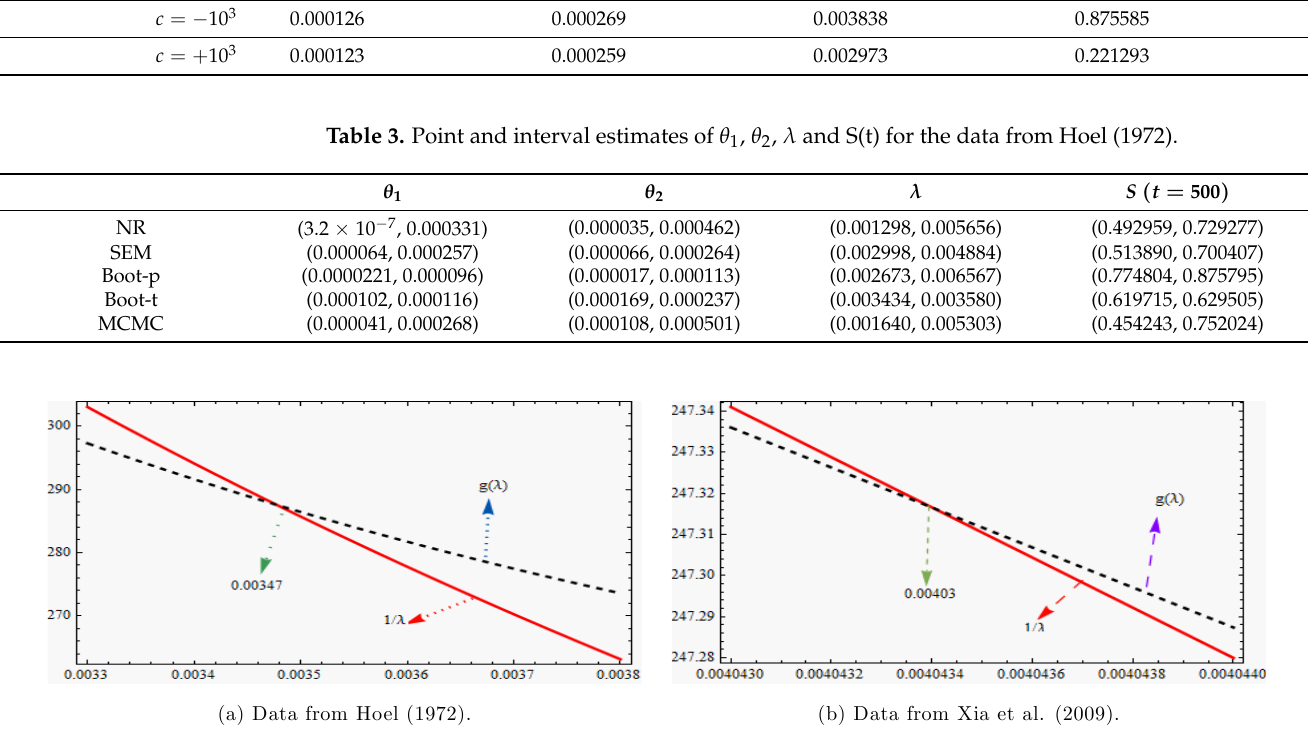
Fig. 3. Graphical technique for obtaining the initial value of (cid:21) ( 1 =(cid:21) is solid red line, and g ( (cid:21) ) is the dashed line). Figure 3. Graphical technique for obtaining the initial value of λ (1/ λ , is solid red line, and g ( λ ) is the dashed